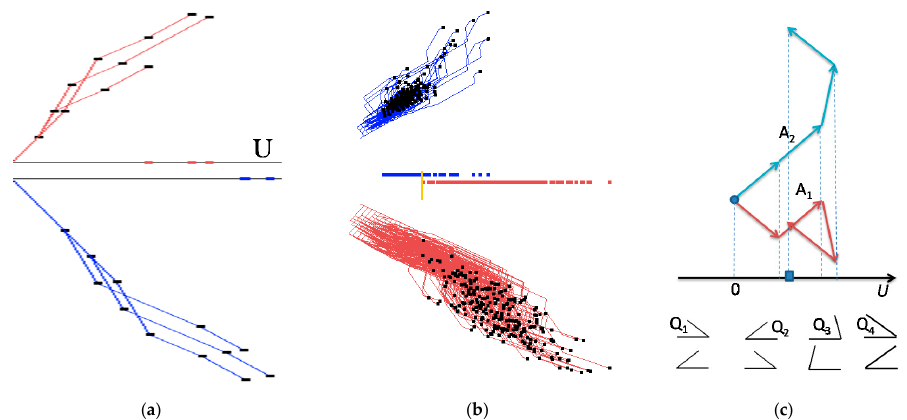
Figure 2. GLC-L algorithm on real and simulated data. ( a ) Result with axis X 1 starting at axis U and repeated for the second class below it; ( b ) Visualized data subset from two classes of Wisconsin breast cancer data from UCI Machine Learning Repository [17]; ( c ) 4-D point A = ( − 1,1, − 1,1) in two representations A 1 and A 2 in GLC-L coordinates X 1 – X 4 with angles Q 1 – Q 4 .